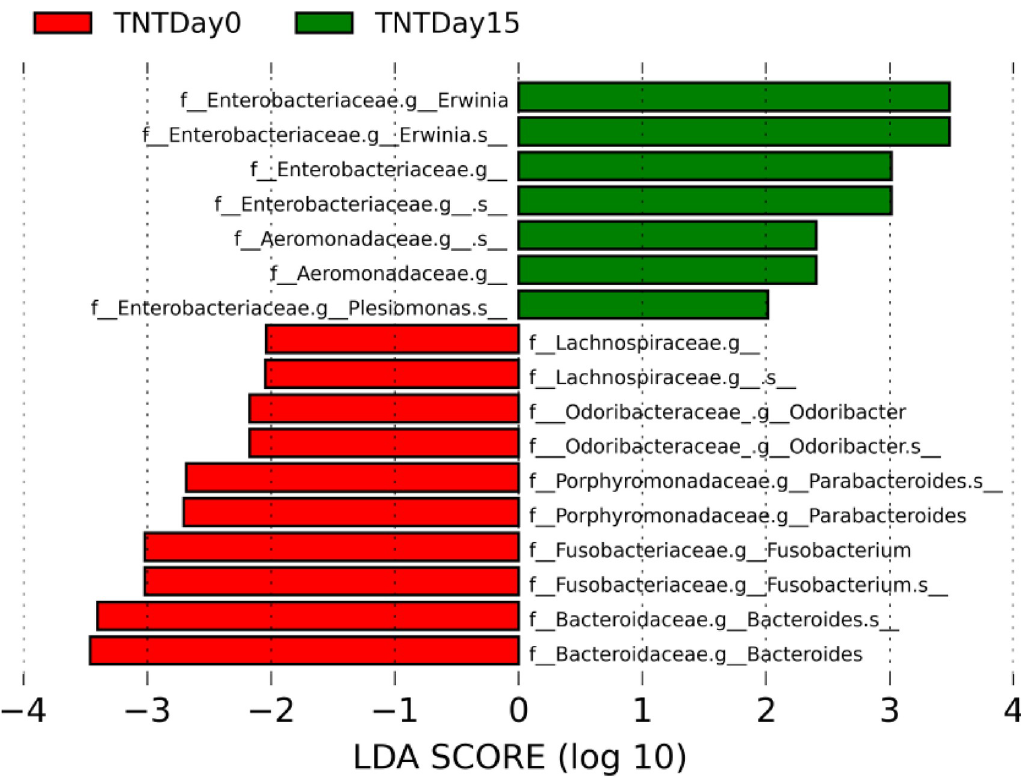
Fig 5. Species level taxonomic histogram representation of LEfSe analysis of 16S rRNA gene sequences. (Green) Taxa significantly associated with TNT dosed anoles at day 15; (Red) taxa significantly associated with TNT dosed anoles at day 0. Significance determined using default parameters (Kruskal Wallis test p < 0.05 and LDA score > 2). Magnitude of each bar represents the effect size.